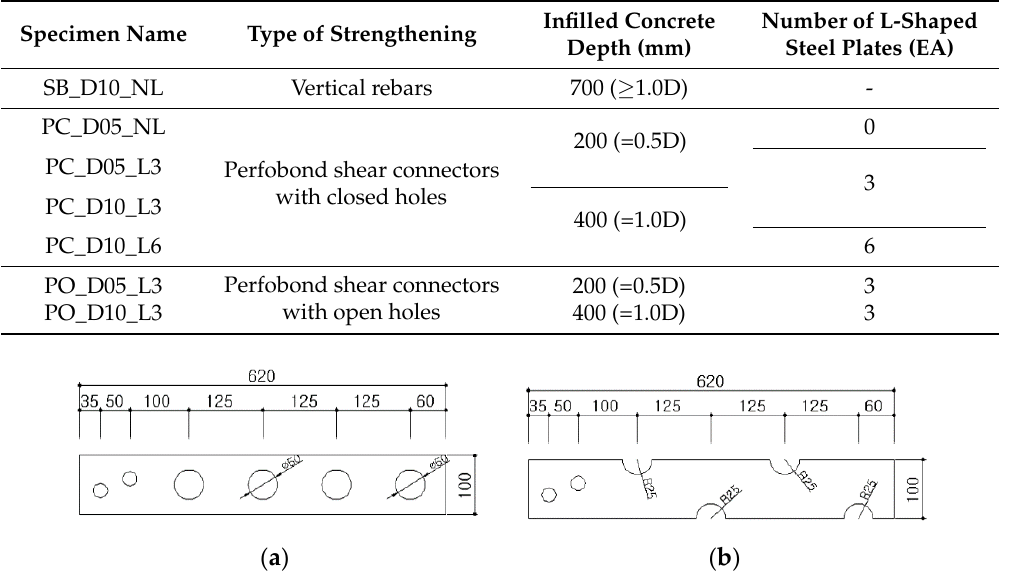
Figure 4. Types of perfobond shear connectors. ( a ) Perfobond shear connector with closed holes. ( b ) Perfobond shear connectors with open holes. (unit: mm).